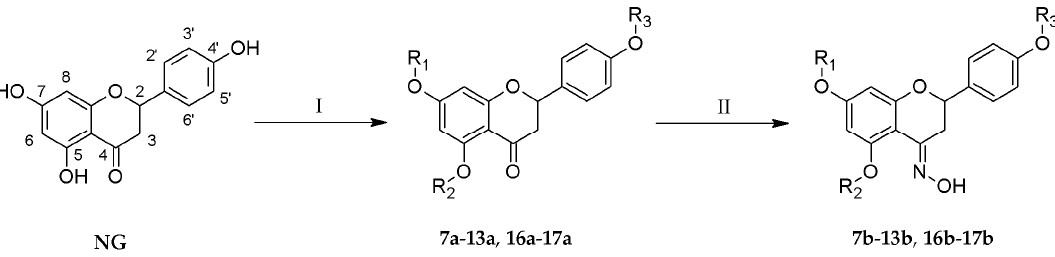
Figure 1. Synthesis of novel O -alkyl derivatives 7a – 13a and 16a – 17a and their oximes 7b – 13b and 16b – 17b ; Reaction conditions: (I) alkyl iodide, (CH 3 ) 2 CO or DMF, K 2 CO 3 , 40–45 °C, 40–96 h; (II) NH 2 OH·HCl, CH 3 COONa, EtOH, 40–50 °C, 24–96